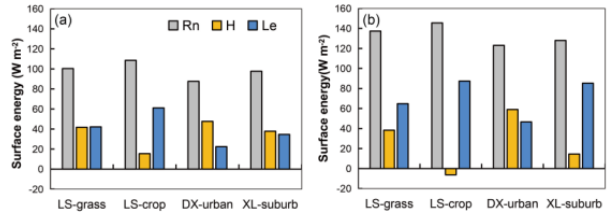
Figure 9. Seasonal average distribution of surface energy for the (a) spring and (b) summer at the four sites in